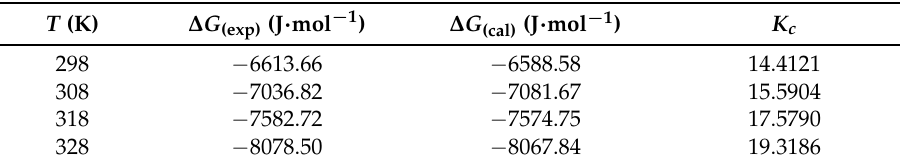
Table 3. The thermodynamic parameters.